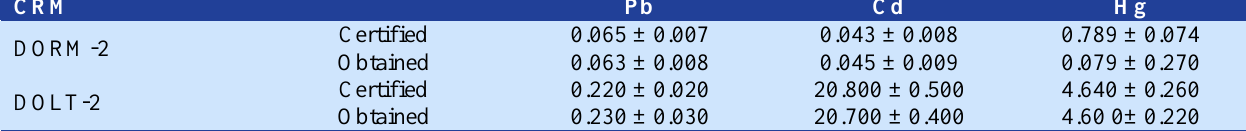
Table 2. Comparison of the obtained and reference concentrations (µg/g dry weight)